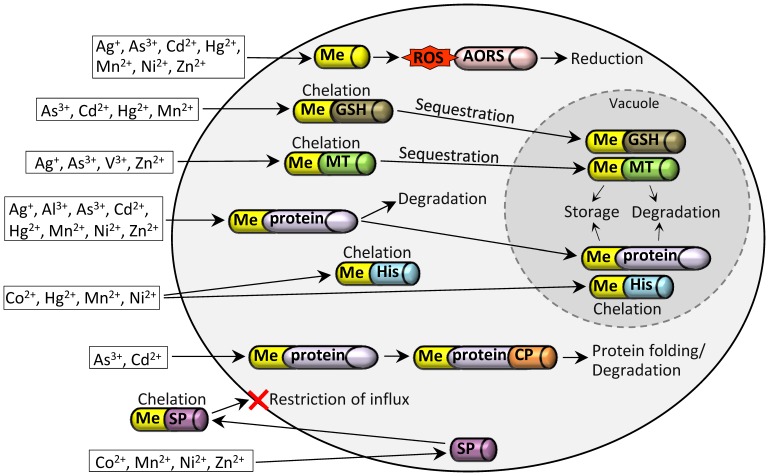
Schematic model of detoxification responses under acute metal stress.Activation of the antioxidative redox system (AORS) to reduce reactive oxygen species (ROS); Chelation of metal ions (Me) via glutathione (GSH) and metallothionein (MT), sequestration of chelates into the vacuole, storage of metal ions and degradation of proteins, respectively; Extracellular chelation of metals via siderophores (SP) to restrict metal influx; Chelation of metals via histidine (His); Vacuolar and non-vacuolar degradation of metal/protein complexes; Activation of chaperones (CP) for protein folding and degradation of metal/protein complexes.